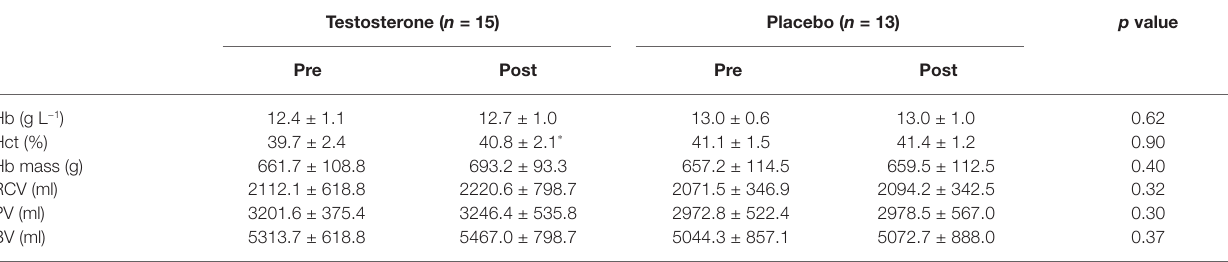
TABLE 2 | Hemoglobin (Hb) mass and intravascular volumes before and after the